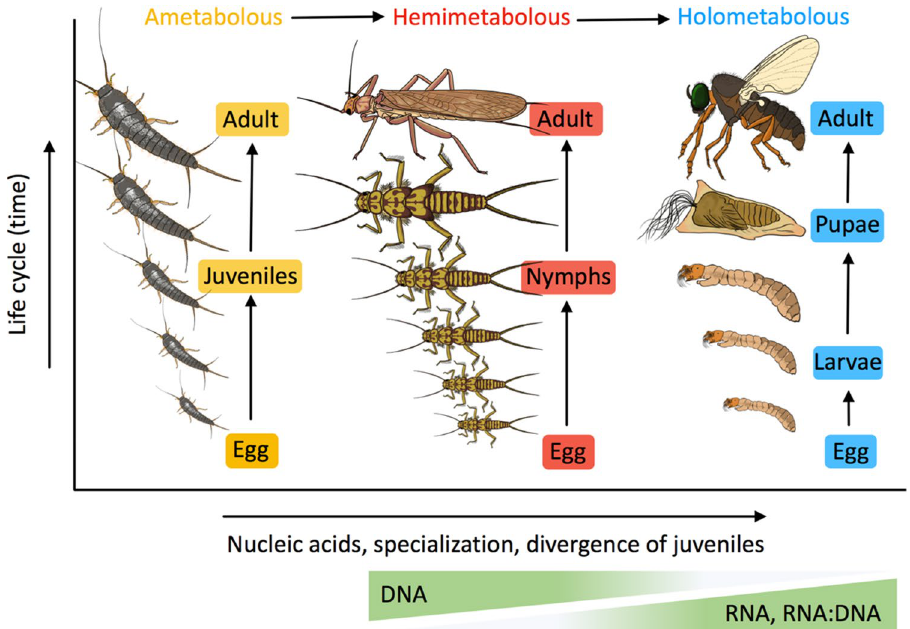
Figure 4. Scheme illustrating the changes in nucleic acid composition in the evolution of insect postembryonic development. Amber represents the ancestral ametabolous mode, red the hemimetabolous mode characterized by nymphs with numerous instars, and blue the holometabolous mode characterized by larvae with fewer moult events before the pupa stage. No ametabolous species were analysed for nucleic acids in this study. The image is credit by I. Peralta-Maraver under CC BY open access copyright, and is based on Belles 3